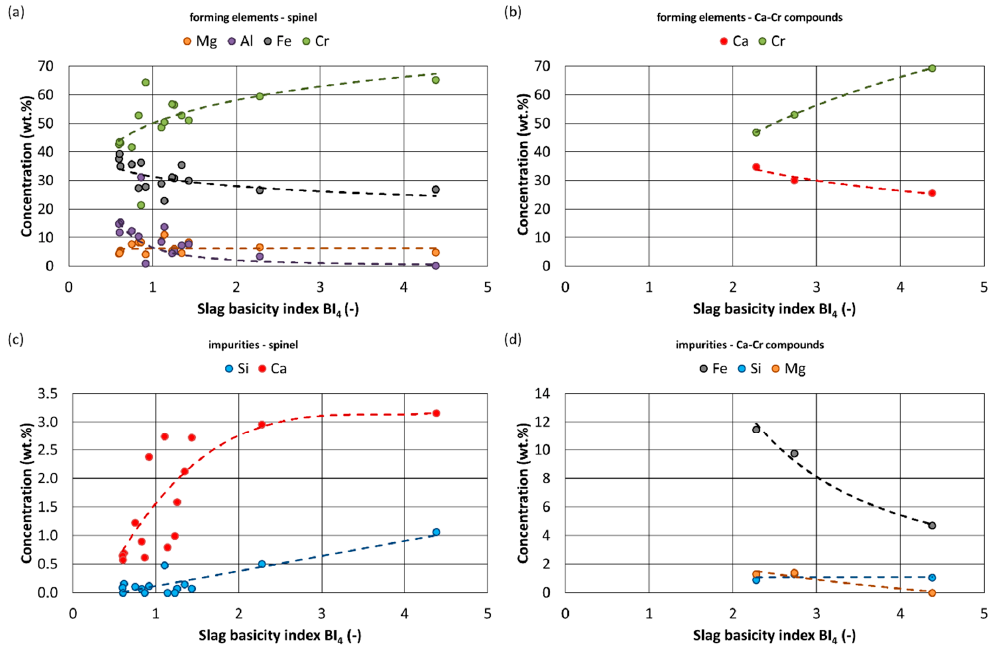
Figure 5. Elements distribution within the Cr-bearing phases: forming-elements in ( a ) spinel and ( b ) Ca-Cr compounds; impurities in ( c ) spinel and ( d ) Ca-Cr compounds.